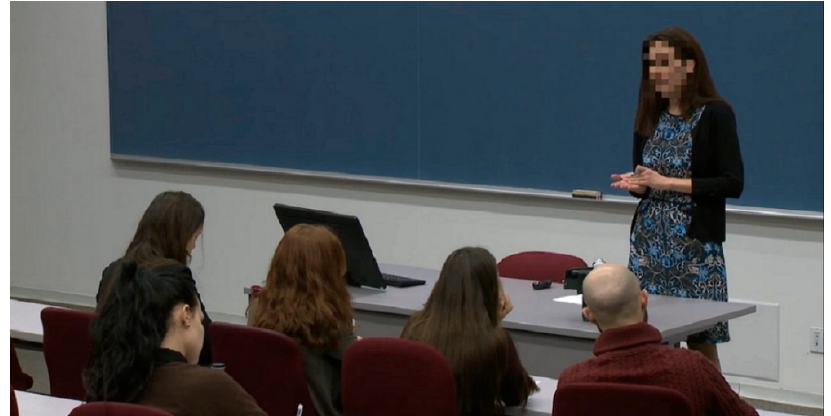
Figure 2. Lecture condition screenshot. Table 1. Research stimuli in comparison.